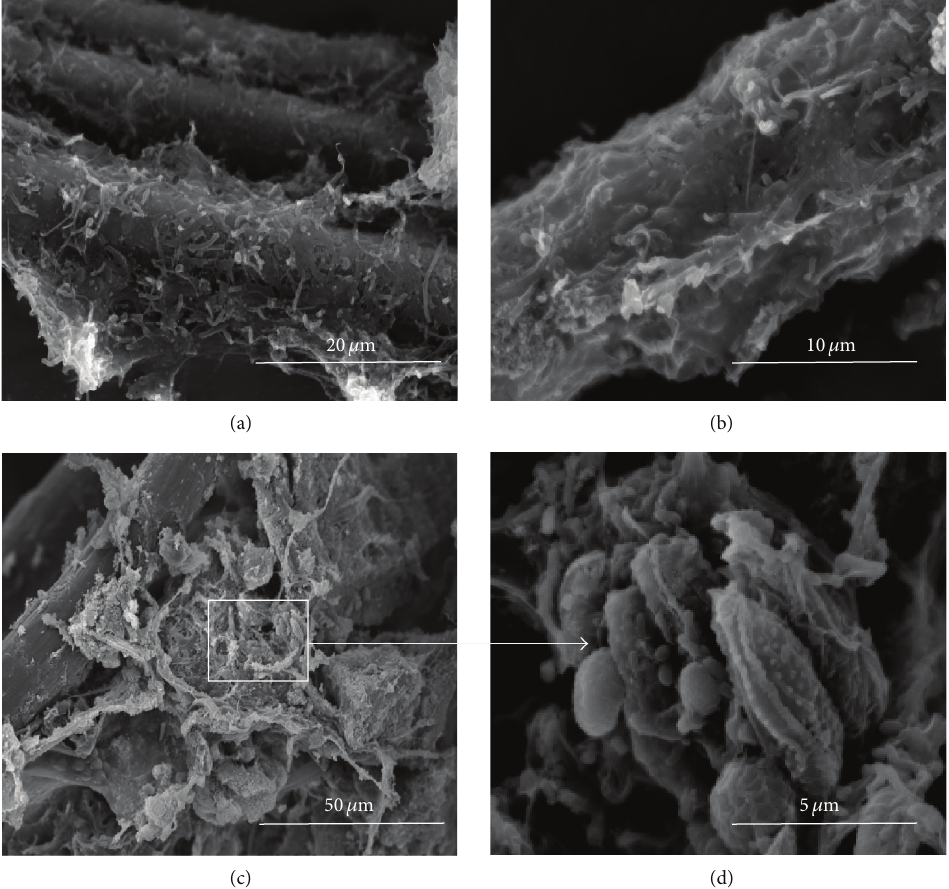
Figure 4: (a) and (b) SEM images of the anode biofilms; (c) and (d) SEM images of the cathode biofilms.